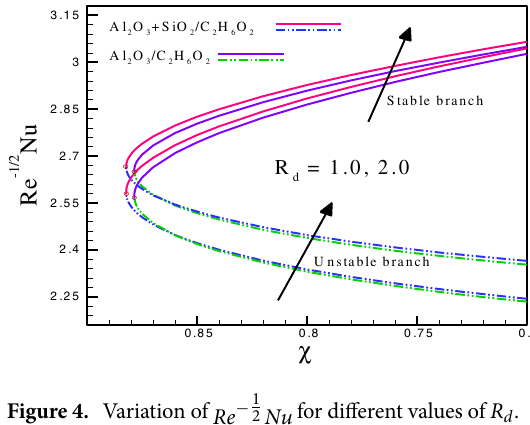
Figure 4. Variation of Re −